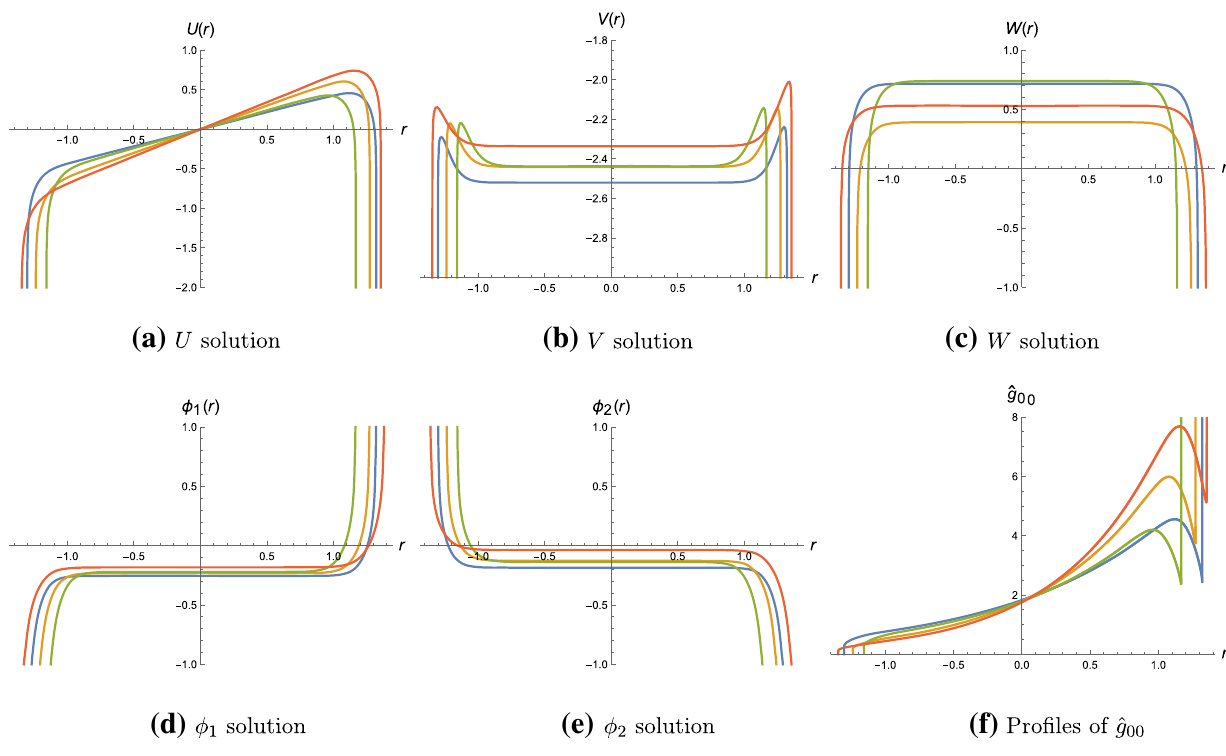
Fig. 20 RG flows between AdS 3 × S 2 × H 2 fixed points and curved domain walls for SO ( 2 ) × SO ( 2 ) twist in SO ( 3 , 2 ) gauge group. The blue, orange, green and red curves refer to ( z 1 , z 2 ) = ( 1